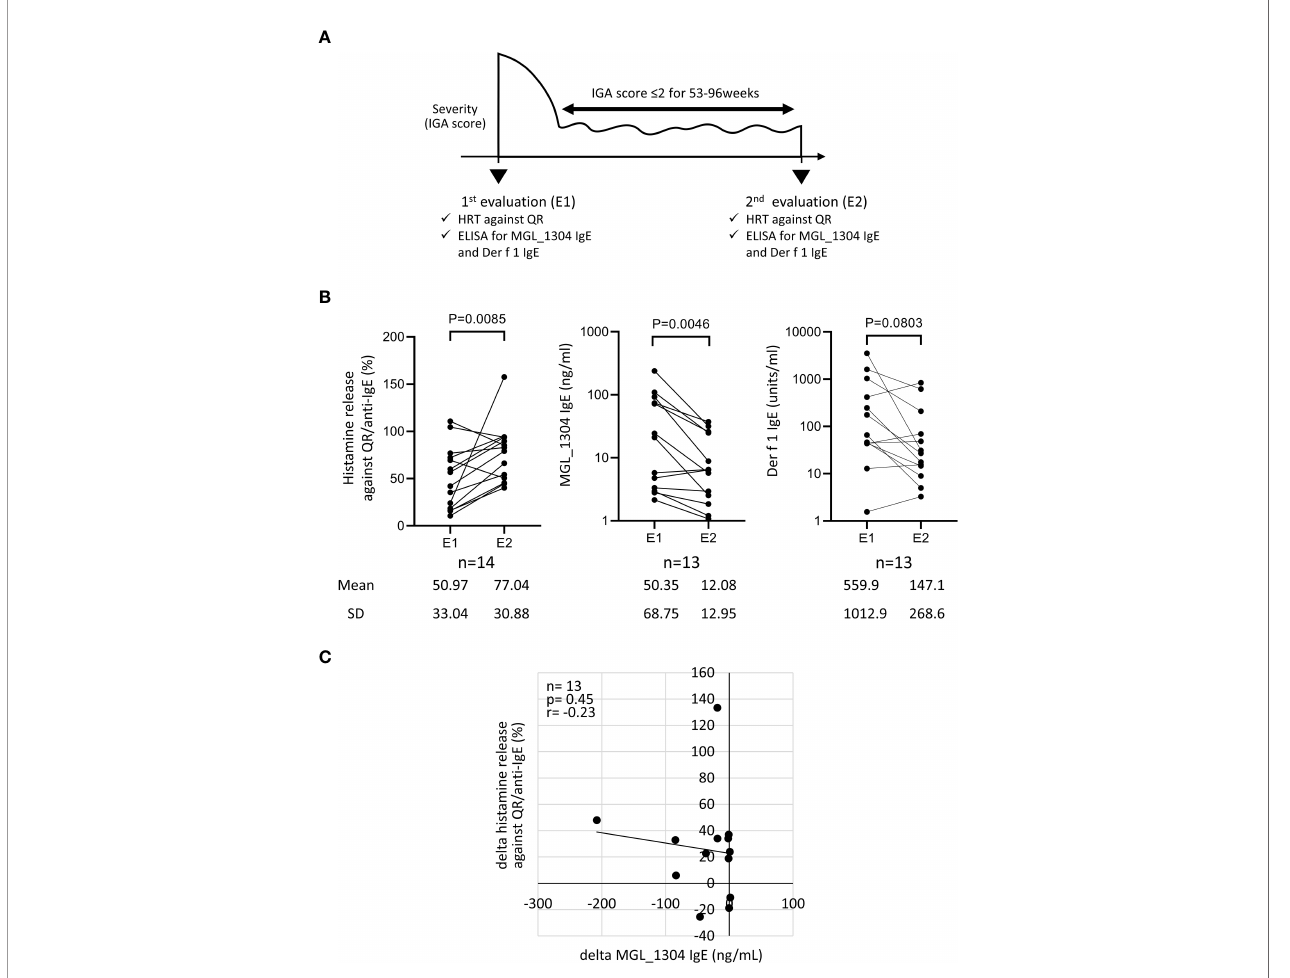
FIGURE 1 | (A) Study design. (B) Histamine release from basophils in response to the semi-puri fi ed sweat antigen (QR) and levels of IgE to MGL_1304 and Der f 1 at E1 and E2 in total participants. (C) Correlation of the change of histamine release in response to QR to that of MGL_1304 IgE. Histamine release was expressed as (net % of histamine release induced by QR)/(net % of histamine release induced by anti-human IgE)×100 (%). “ delta ” means the changes of parameters calculated by the subtraction of values at E1 from those at E2. E1, the 1st evaluation; E2, the 2nd evaluation; HRT, histamine release test; IGA, Investigator ’ s Global